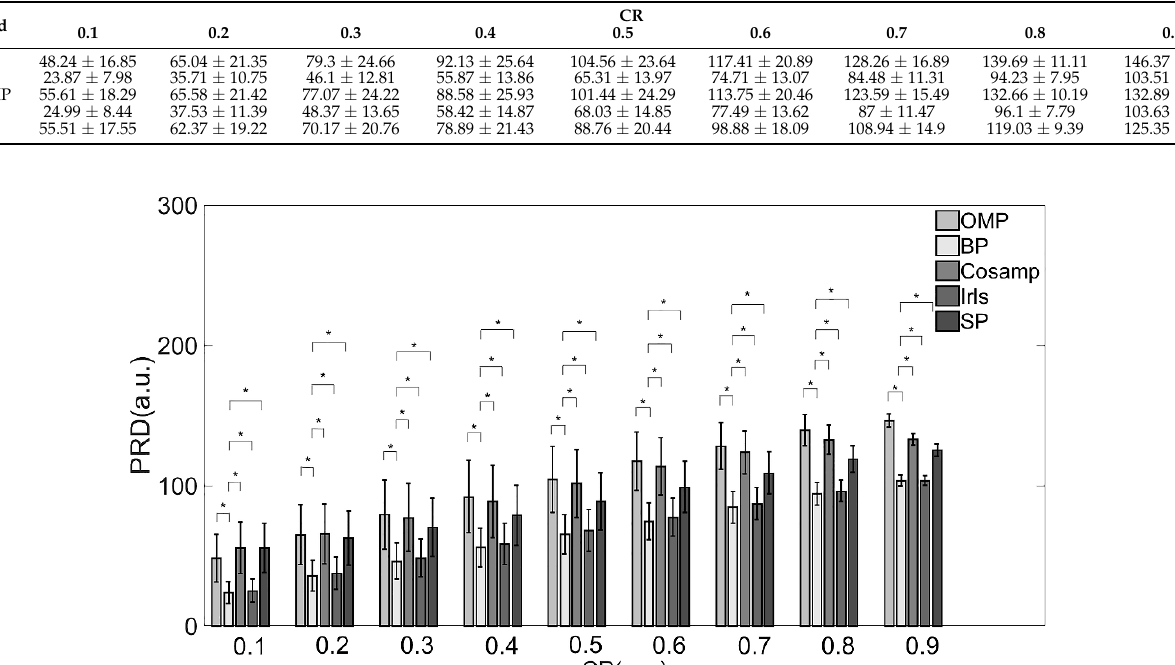
Figure 3. PRD values of various reconstruction algorithms. Note: * Indicates statistical significance via two-sample t -tests. Table 2. PRD values of the reconstruction signals for the different compression ratios (CRs) based on the same wavelet basis. Values are means ± SD.